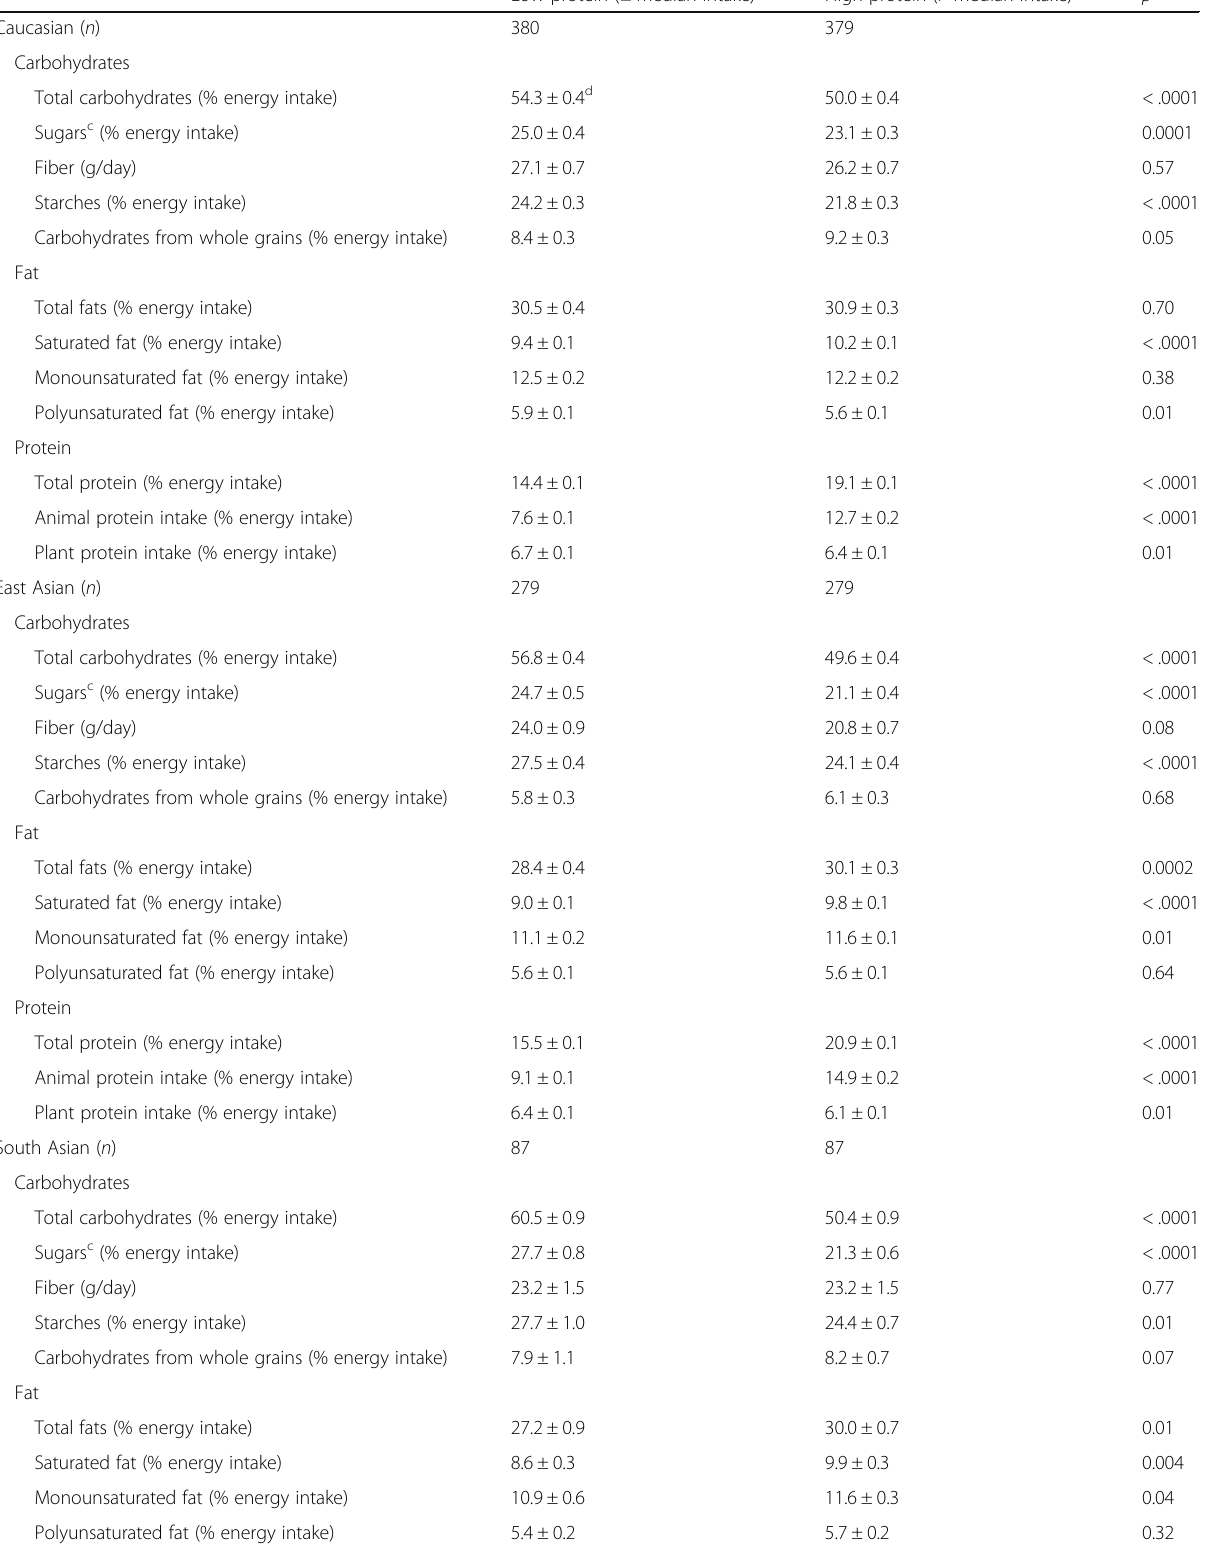
Table 4 Macronutrient intake in high- and low-protein consumers stratified by